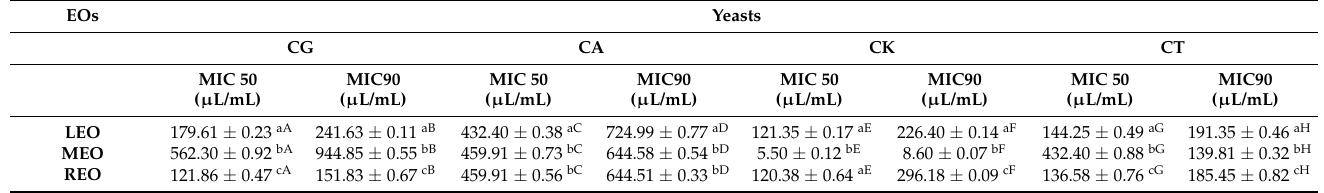
Table 6. Antimicrobial activity of EOs expressed as the minimum inhibitory concentration (MIC) in µ L/mL against yeasts.